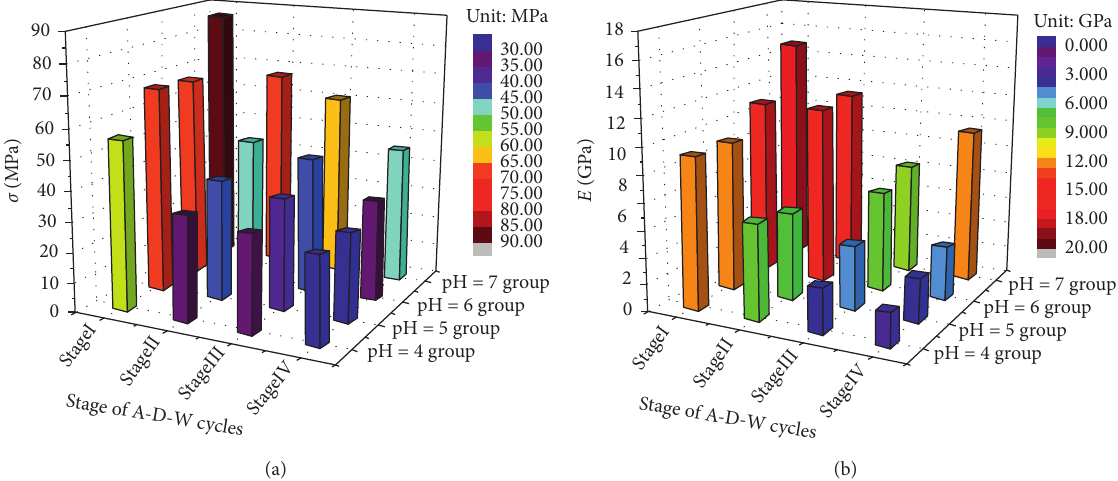
Figure 10: Effects of the A-D-W cycle on peak stress and elastic modulus under different groups: (a) relation of dynamic compressive strength under different stages and (b) relation of elastic modulus under different stages.